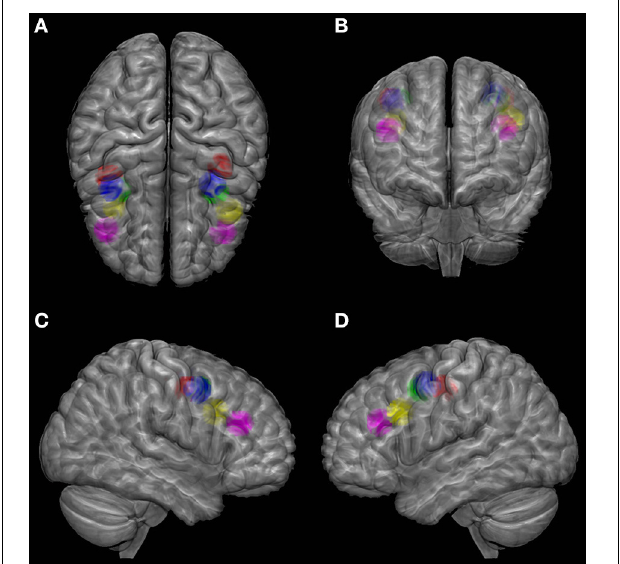
FIGURE 1 | Localization of FEF according to several studies on the MNI (Montreal Neurological Institute) brain template viewed from top (A), front (B), right (C) and left (D). Color codes as follows. Green: meta-analysis of PET studies from Paus (1996); Blue: fMRI study of Luna et al. (1998); Red: fMRI study of Petit and Haxby (1999); Yellow: MEG study of Ioannides et al. (2004); Purple: coordinates estimated by Tehovnik et al. (2000) based on the PET study of Kawashima et al. (1998). A sphere of 1cm radius is positioned at the center of FEF activation from each study. SPM (Statistical Parametric Mapping, http://www . fil . ion . ucl . ac . uk/spm/) with MarsBar toolbox was used to design the spheres and MRIcroGL software (http://www . mccauslandcenter . sc . edu/mricrogl/) was used for glass brain